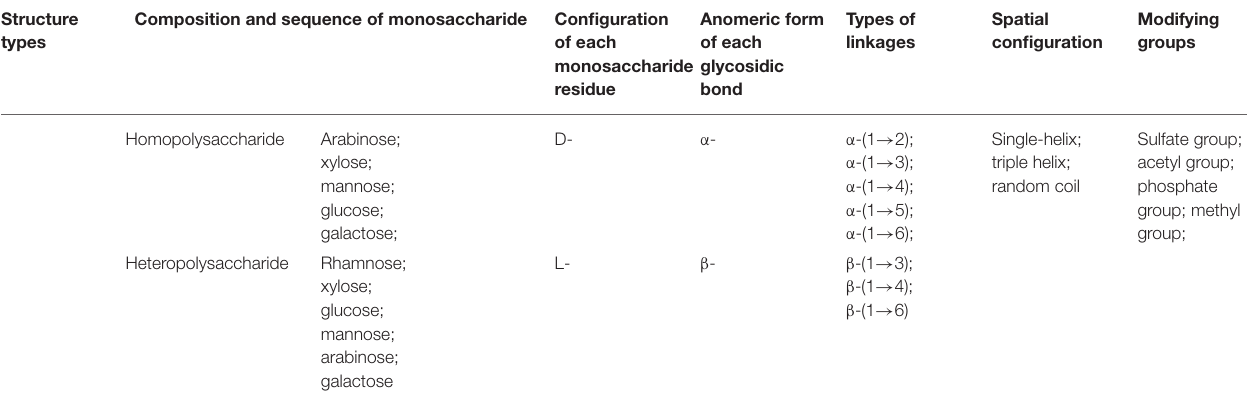
TABLE 3 | Types and structural diversity of